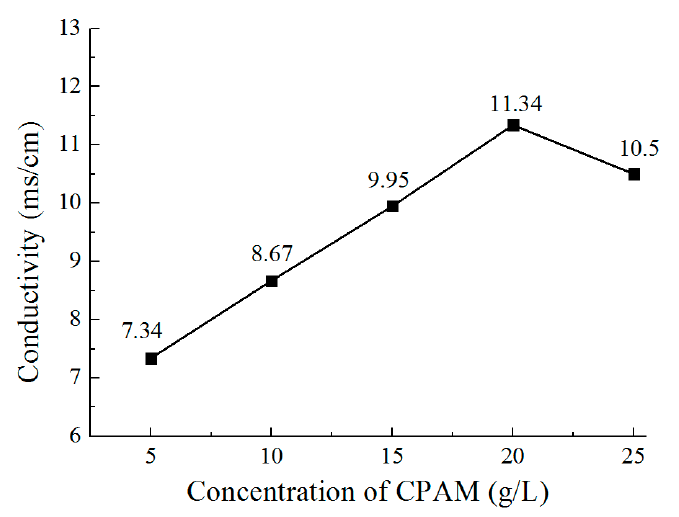
Figure 6. The conductivity of the electrolyte with different concentrations of CPAM. Accordingly, the deposition results are shown in Figures 7 and 8. With a concentration of 5 g/L in CPAM, zinc deposition with spherical grains at an average size of 847 nm is formed on the surface, but the distribution of the grains is not uniform. When the concentration is increased to 10 g/L, the grains become blocky in structure with a size of 405 nm, and the distribution of the grains become uniform. When the concentration is increased from to 15 to 20 g/L, the grains are further refined, and the size reduces from 183 nm to 87 nm. However, with the concentration of 25 g/L, it can be seen that compared to that at 20 g/L, the uniformity of the grains becomes poor, and the average size increases to 124